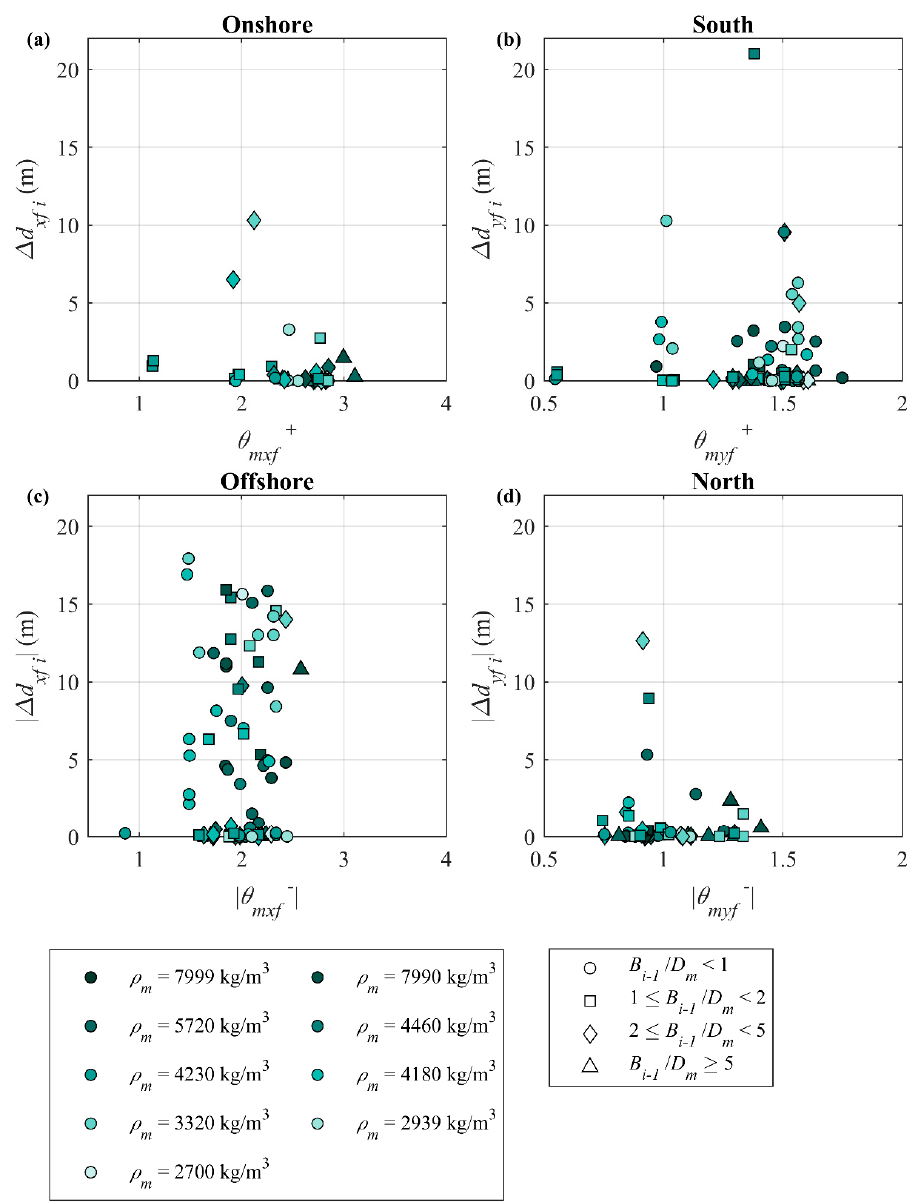
Figure 16. Long term field deployed munition observations. Comparison between migration distance components and object mobility number: ( a ) Offshore, ( b ) South, ( c ) Offshore, ( d ) North. Markers are color coded to indicate munition density. Marker symbols indicate the initial dimensionless burial depth.